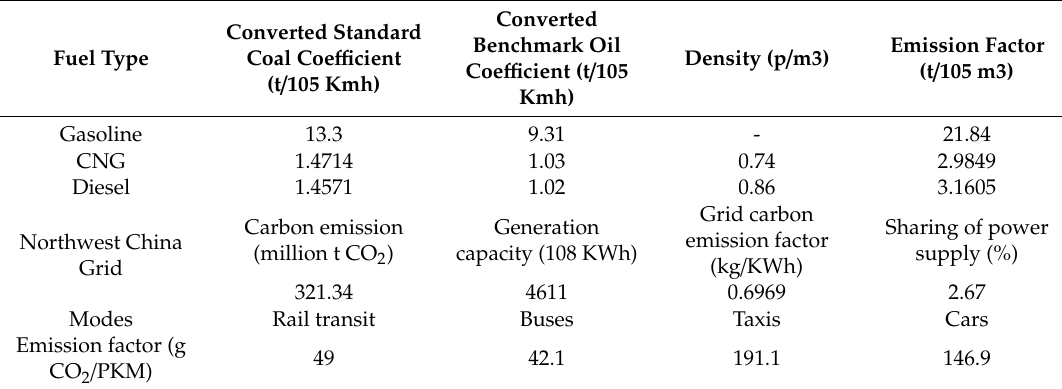
Table 2. Carbon emission factor for fuel and